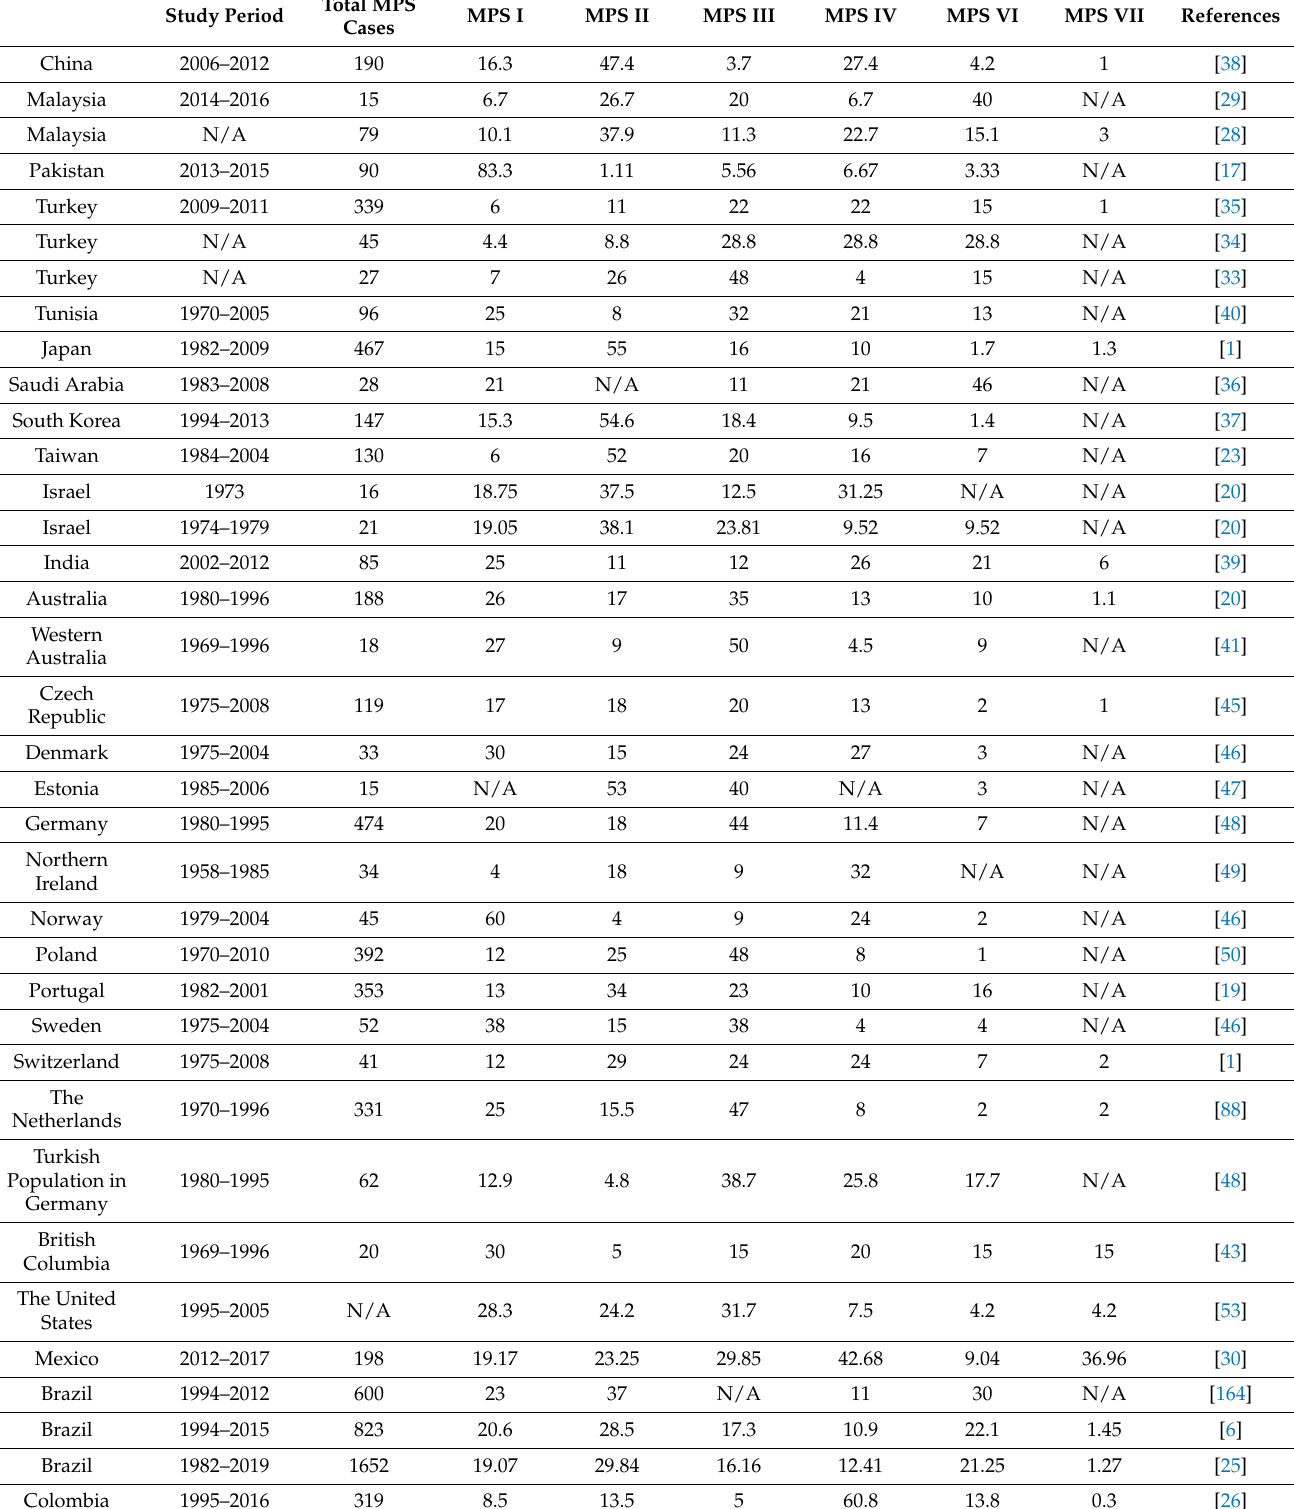
Table 3. Incidence of MPS in 29 countries